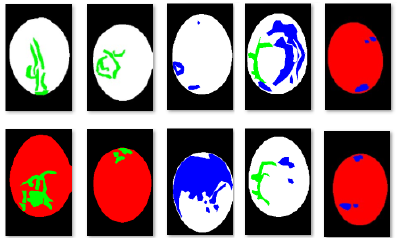
Figure 5. Image labeling for training the semantic segmentation model.